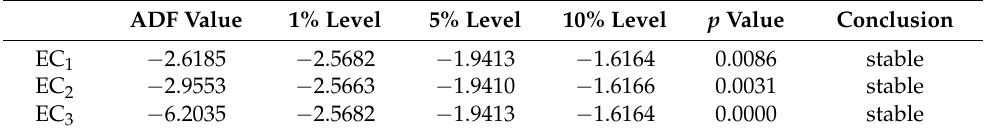
Table 4. Unit root test results of residual